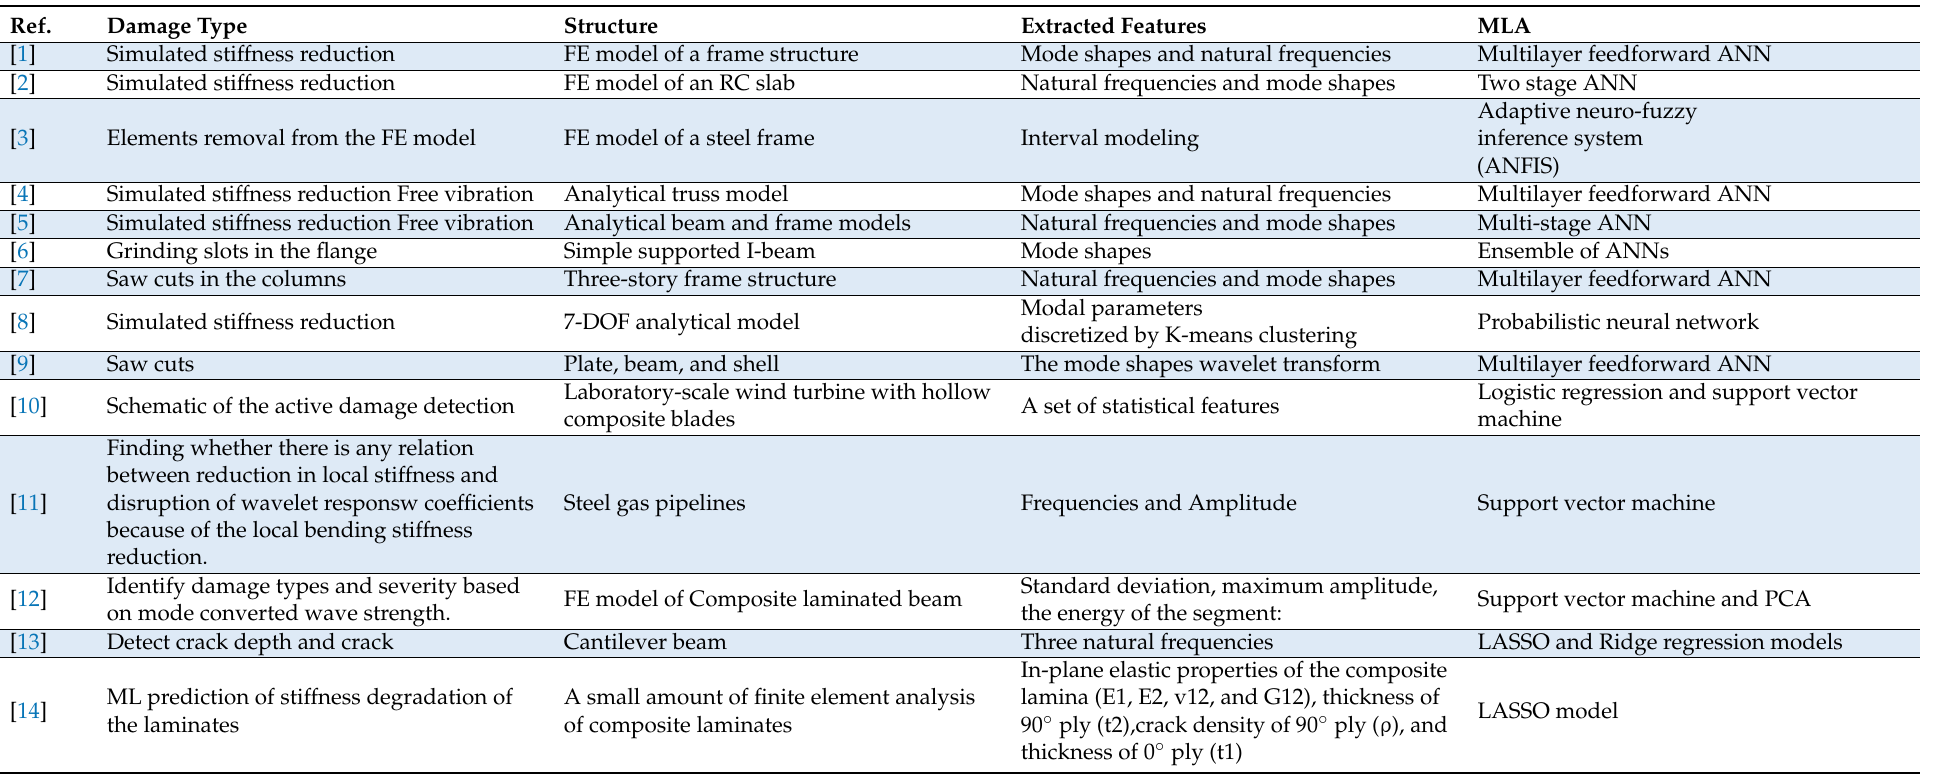
Table 1. More studies employing different machine learning